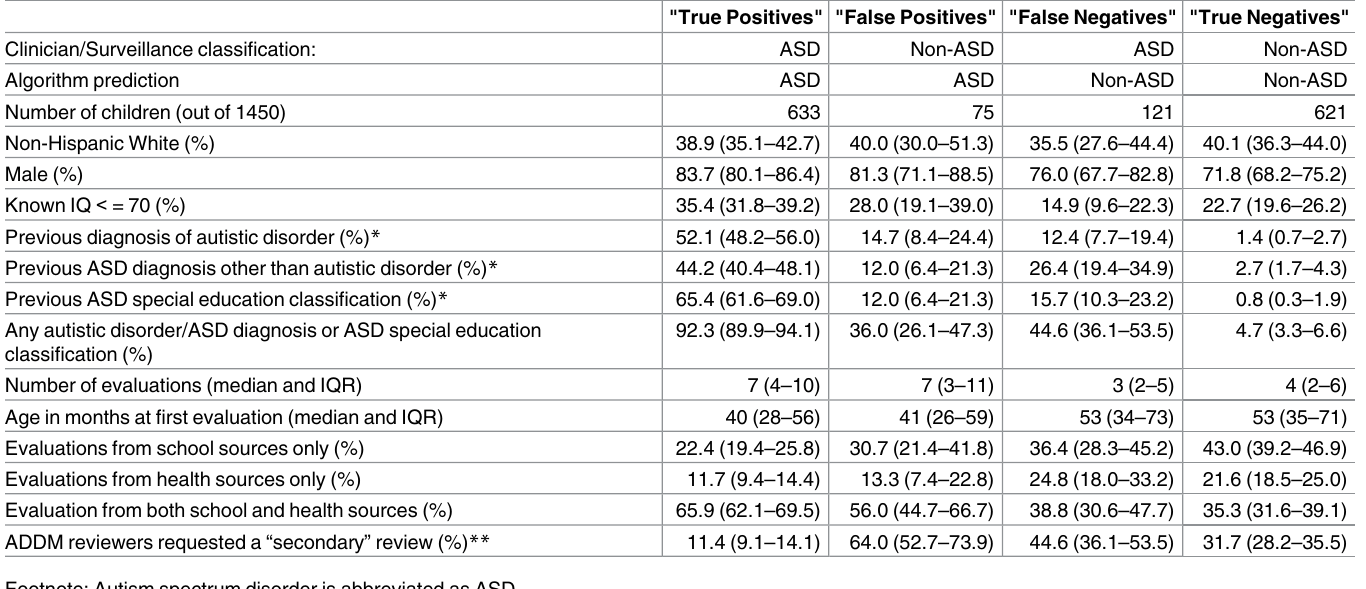
Table 3. Characteristics of children, by algorithm-clinician concordance on autism spectrum disorder (ASD) case